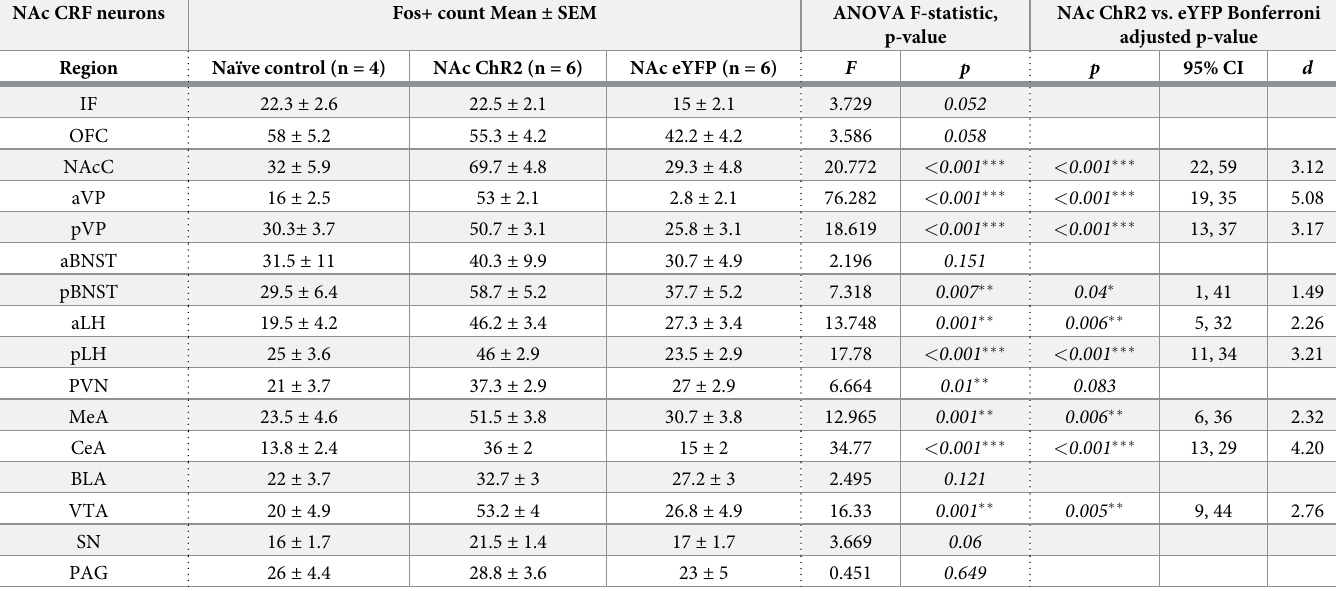
Table shows Fos+ protein quantification in mesocorticolimbic regions after final exposure to ChR2 excitation in NAc (top; n = 3 female, n = 3 male). Fos+ protein quantification in mesocorticolimbic regions (left columns) for na ï ve unoperated control rats, ChR2 rats, and eYFP rats, were compared with a one-way ANOVA for each structure targeted. “Fos+ Count” reflects mean of each group at each site ± standard error (SEM). Follow up two-tailed t-tests with Bonferonni corrections were performed between ChR2, eYFP, and naiive control groups. The right column includes p- values, confidence intervals, and effect sizes for instances where ChR2 rats were found to significantly differ from eYFP controls. Percent change in ChR2 rats from eYFP controls are depicted in Fig 3. IF, infralimbic cortex; OFC, orbitofrontal cortex; aNAcSh, anterior nucleus accumbens shell; pNAcSh, posterior nucleus accumbens shell; NAcC, nucleus accumbens core; aVP, anterior ventral pallidum; pVP, posterior ventral pallidum; aBNST, anterior bed nucleus of stria terminalis; pBNST, posterior bed nucleus of stria terminalis; aLH, anterior lateral hypothalamus; pLH, posterior lateral hypothalamus; PVN, hypothalamic paraventricular nucleus; MeA, medial amygdala; CeA, central amygdala; BLA, basolateral amygdala; VTA, ventral tegmentum; SN, substantia nigra; PAG, midbrain periaqueductal gray. � p < 0.05, �� p < 0.01, ��� p <